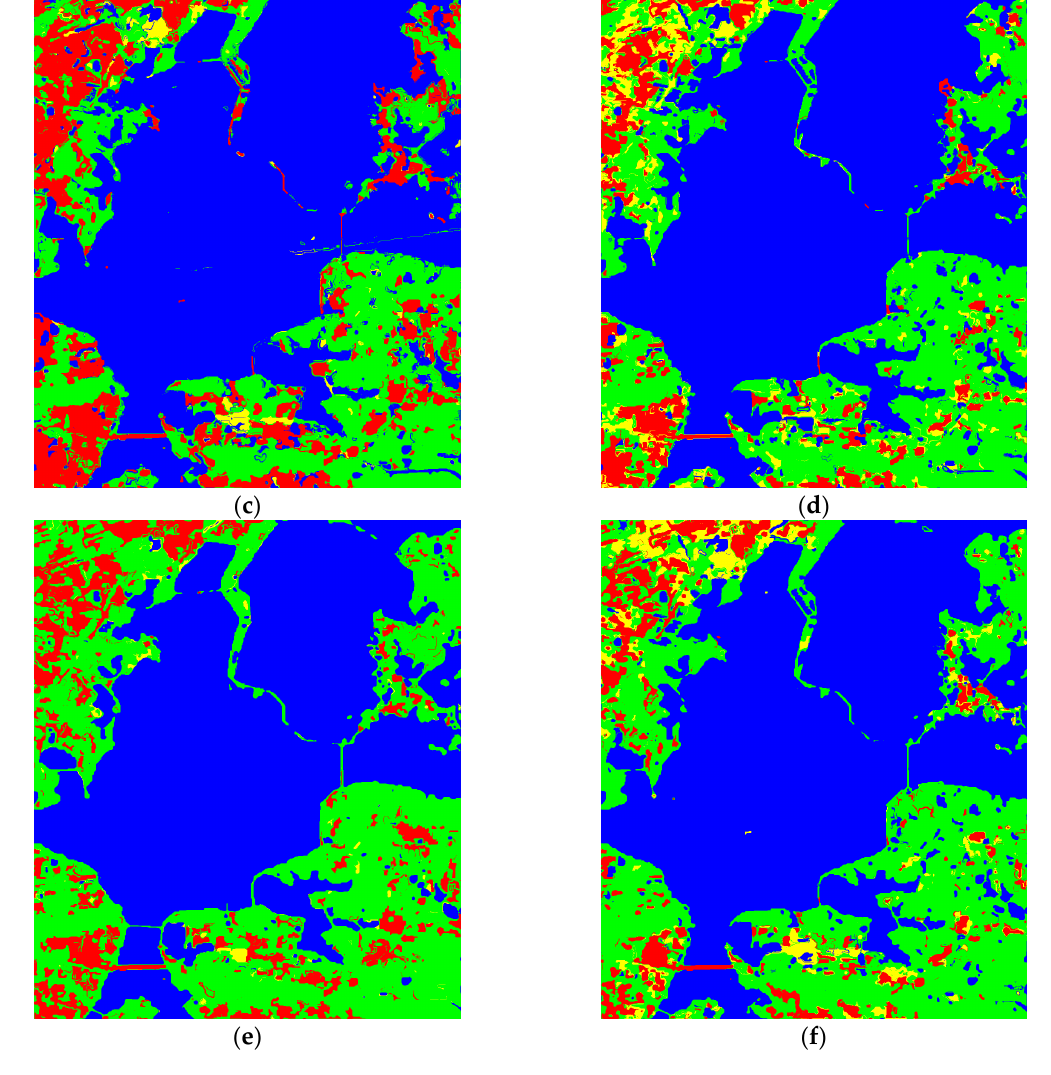
Figure 15. Classification results for the RadarSat-2 imagery with different strategies: ( a ) MBT_pixel; ( b ) MBT_T3; ( c ) RS; ( d ) MI; ( e ) BT; ( f ) MBT.